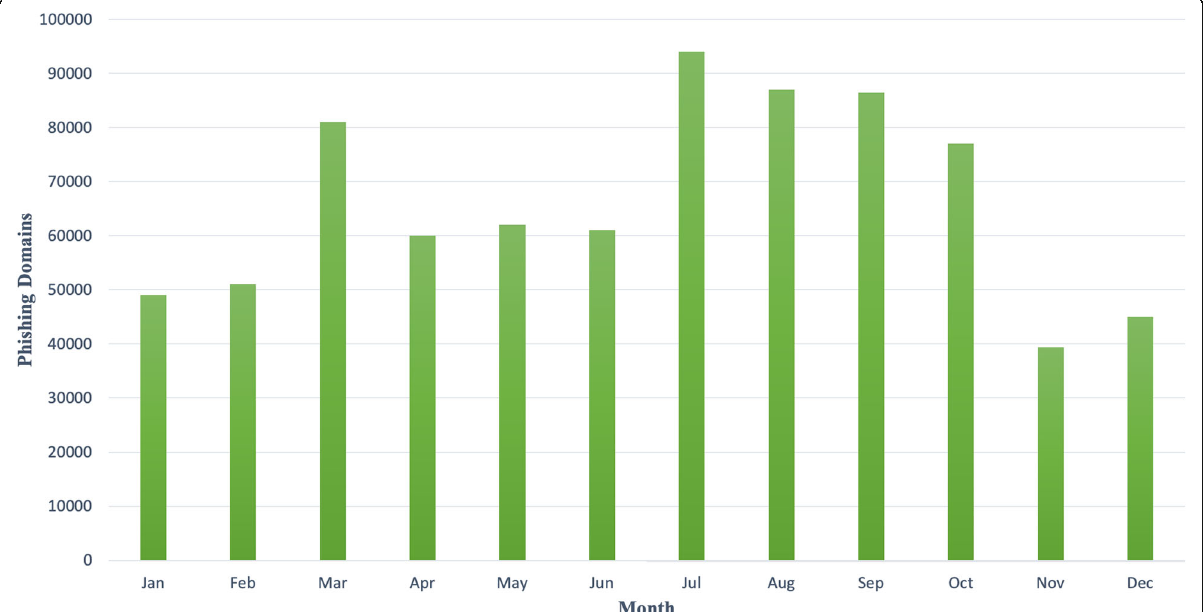
Fig. 1 Phishing Sites 2019 (APWG trends report q1 2019 n.d.; APWG trends report q2 2019 n.d.; APWG trends report q3 2019 PRODUCTION n.d.; APWG trends report q4 2019